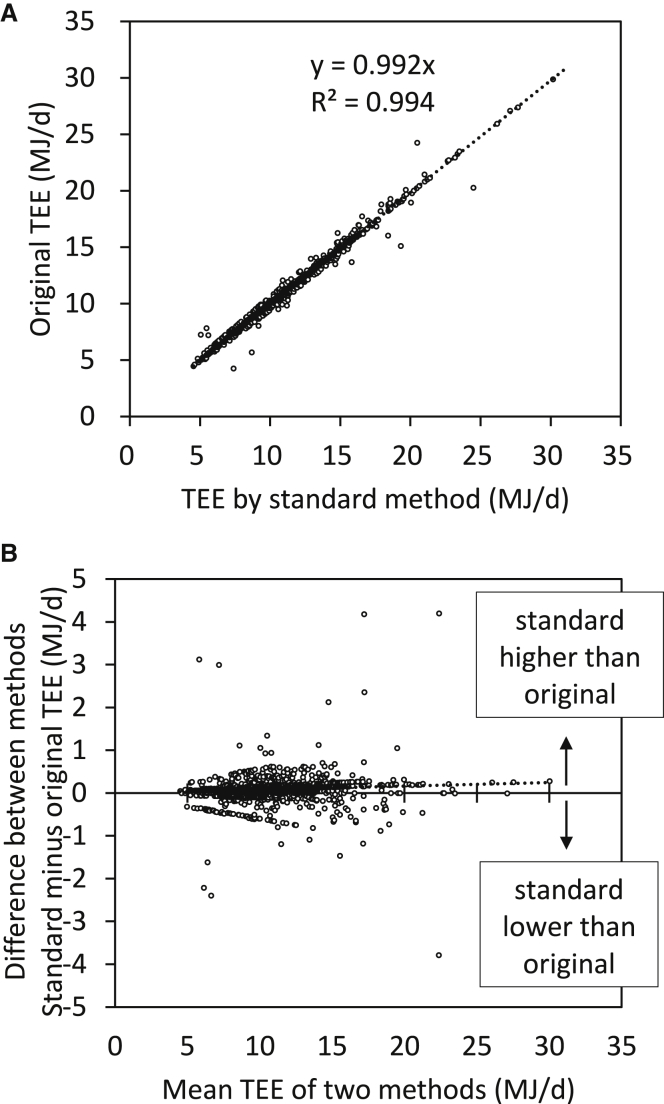
Comparison of published energy expenditure by DLW to that calculated by standard method(A) Relationship between the TEE (MJ/d) for 4,571 individual adults extracted from the original studies and the recalculated TEE using the Weir equation.(B) Bland-Altman plot25 comparing the published TEE with those generated using the recommended equation. Dotted line is average difference. Data refer to data for 4,571 adult individuals uploaded into the IAEA DLW database (v3.1). The sample size is lower than in Figure 1, because for some individuals, estimates of RQ or FQ were not available.